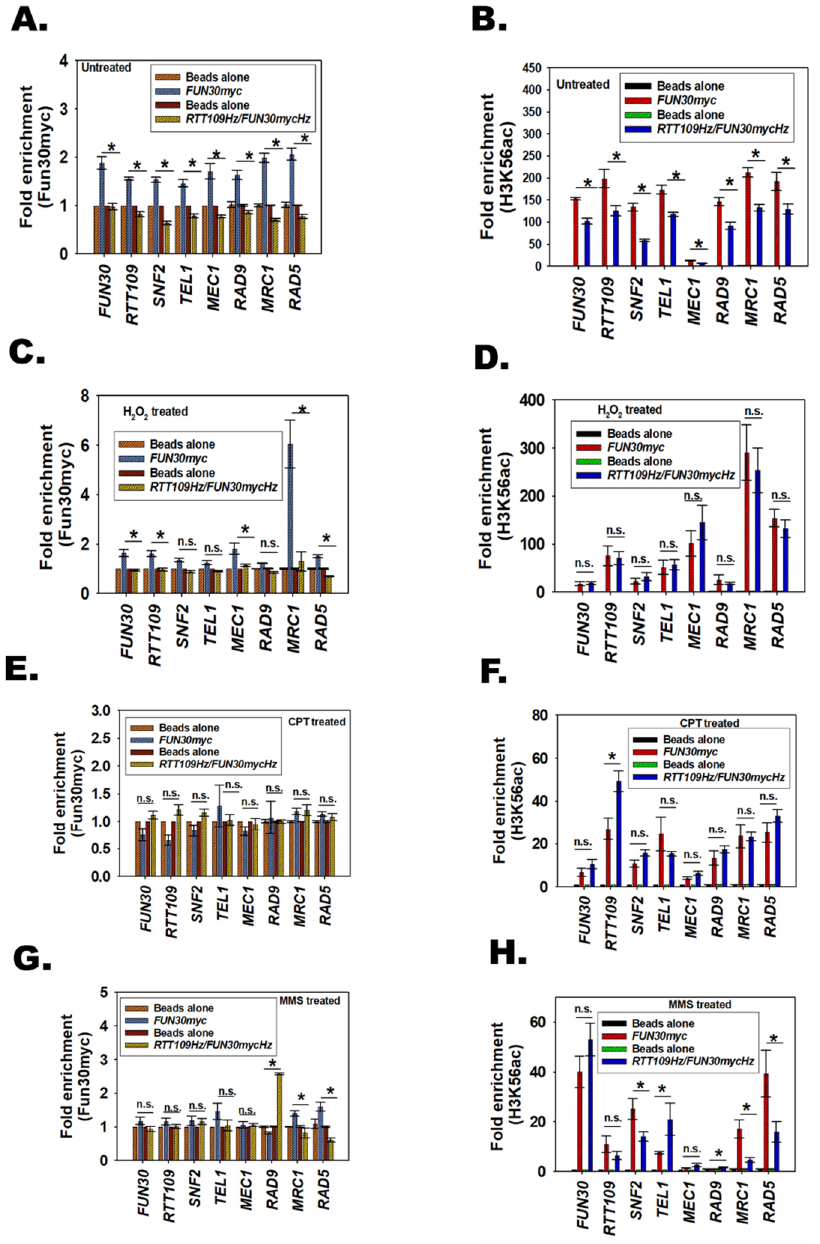
Figure 7. The response of RTT109Hz / FUN30Hz to DNA damage is regulated by the occupancy of Fun30 and H3K56ac on RAD9 , MRC1 , and RAD5 genes. ( A ). The occupancy of Fun30myc was analyzed on FUN30 , RTT109 , SNF2 , TEL1 , MEC1 , RAD9 , MRC1 , and RAD5 promoters in FUN30myc and RTT109Hz/FUN30mycHz in untreated cells. ( B ). The occupancy of H3K56ac was analyzed on